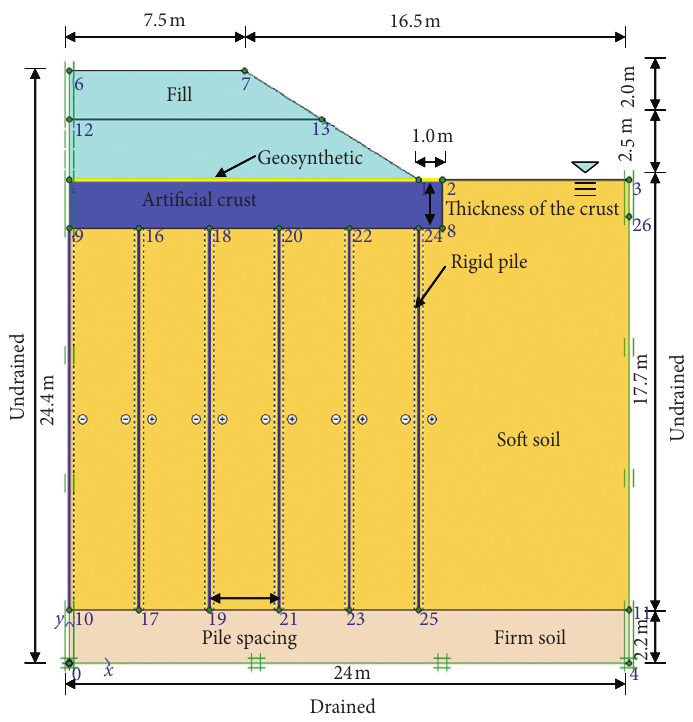
Figure 2: The 2D FE geometry